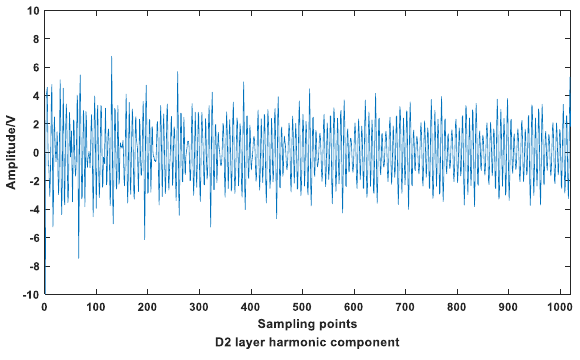
Figure 10. D2 layer reconstruction waveform. Figure-10. D2 layer reconstruction waveform.